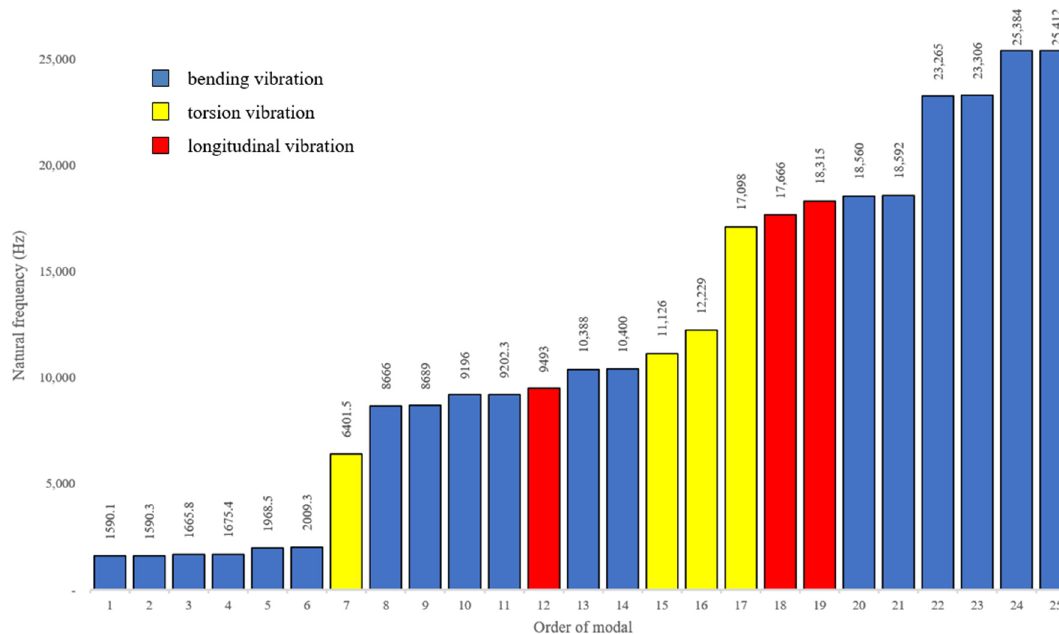
Figure 3. Natural frequency and vibration type of 25 orders of modals.